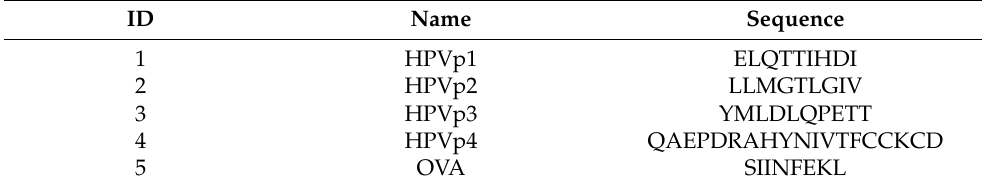
Table 2. Sequence of peptides in article.